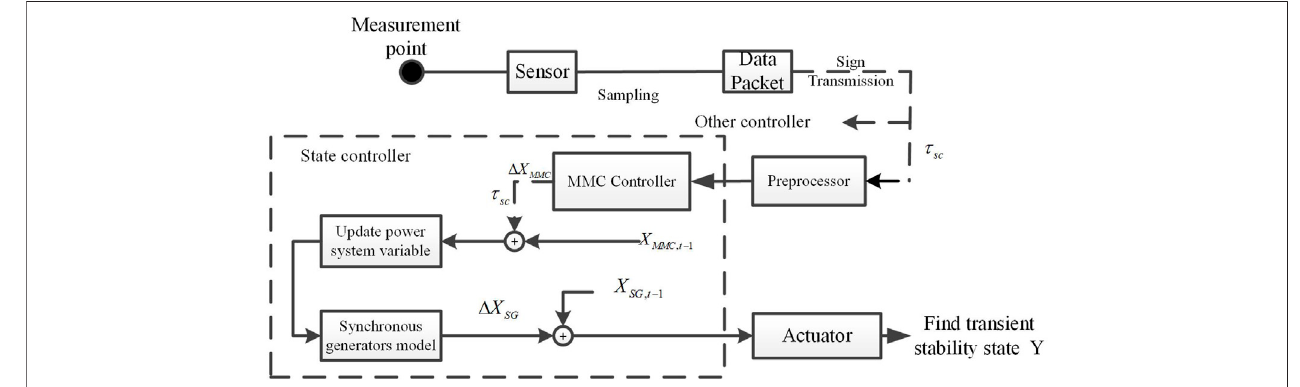
FIGURE 4 | Signal transmission process of the cyber – physical system with the MMC.